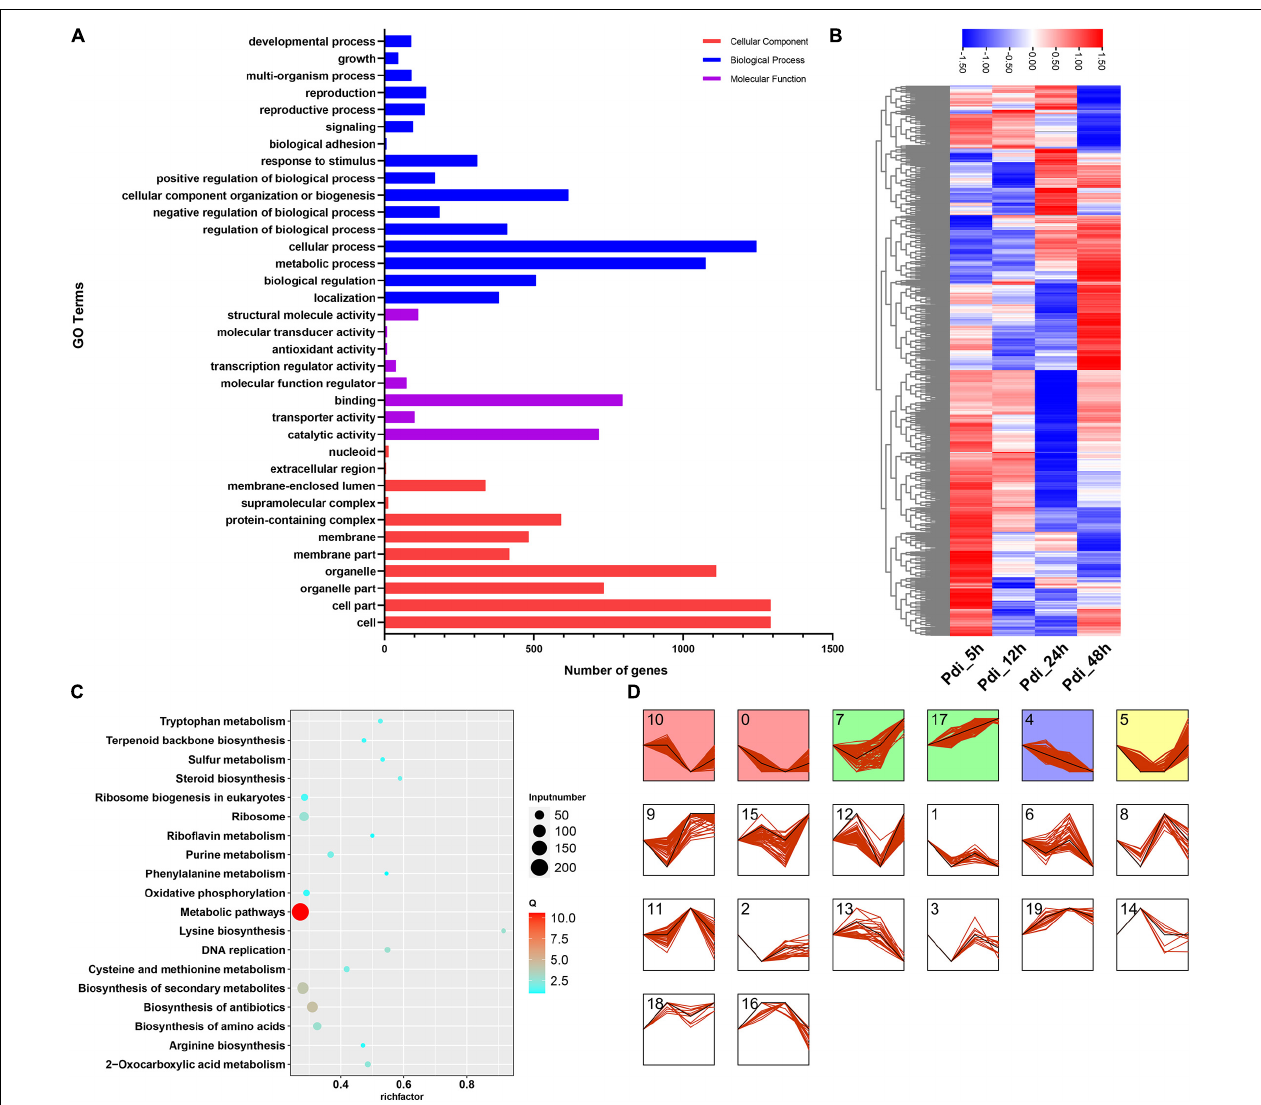
FIGURE 5 | Bioinformatics analyses of DEGs of K. apiculata after co-incubation with P. digitatum . (A) GO category of total DEGs. (B) KEGG enrichment pathway of total DEGs. (C) Heat map of common DEGs. (D) Expression patterns analysis of DEGs.